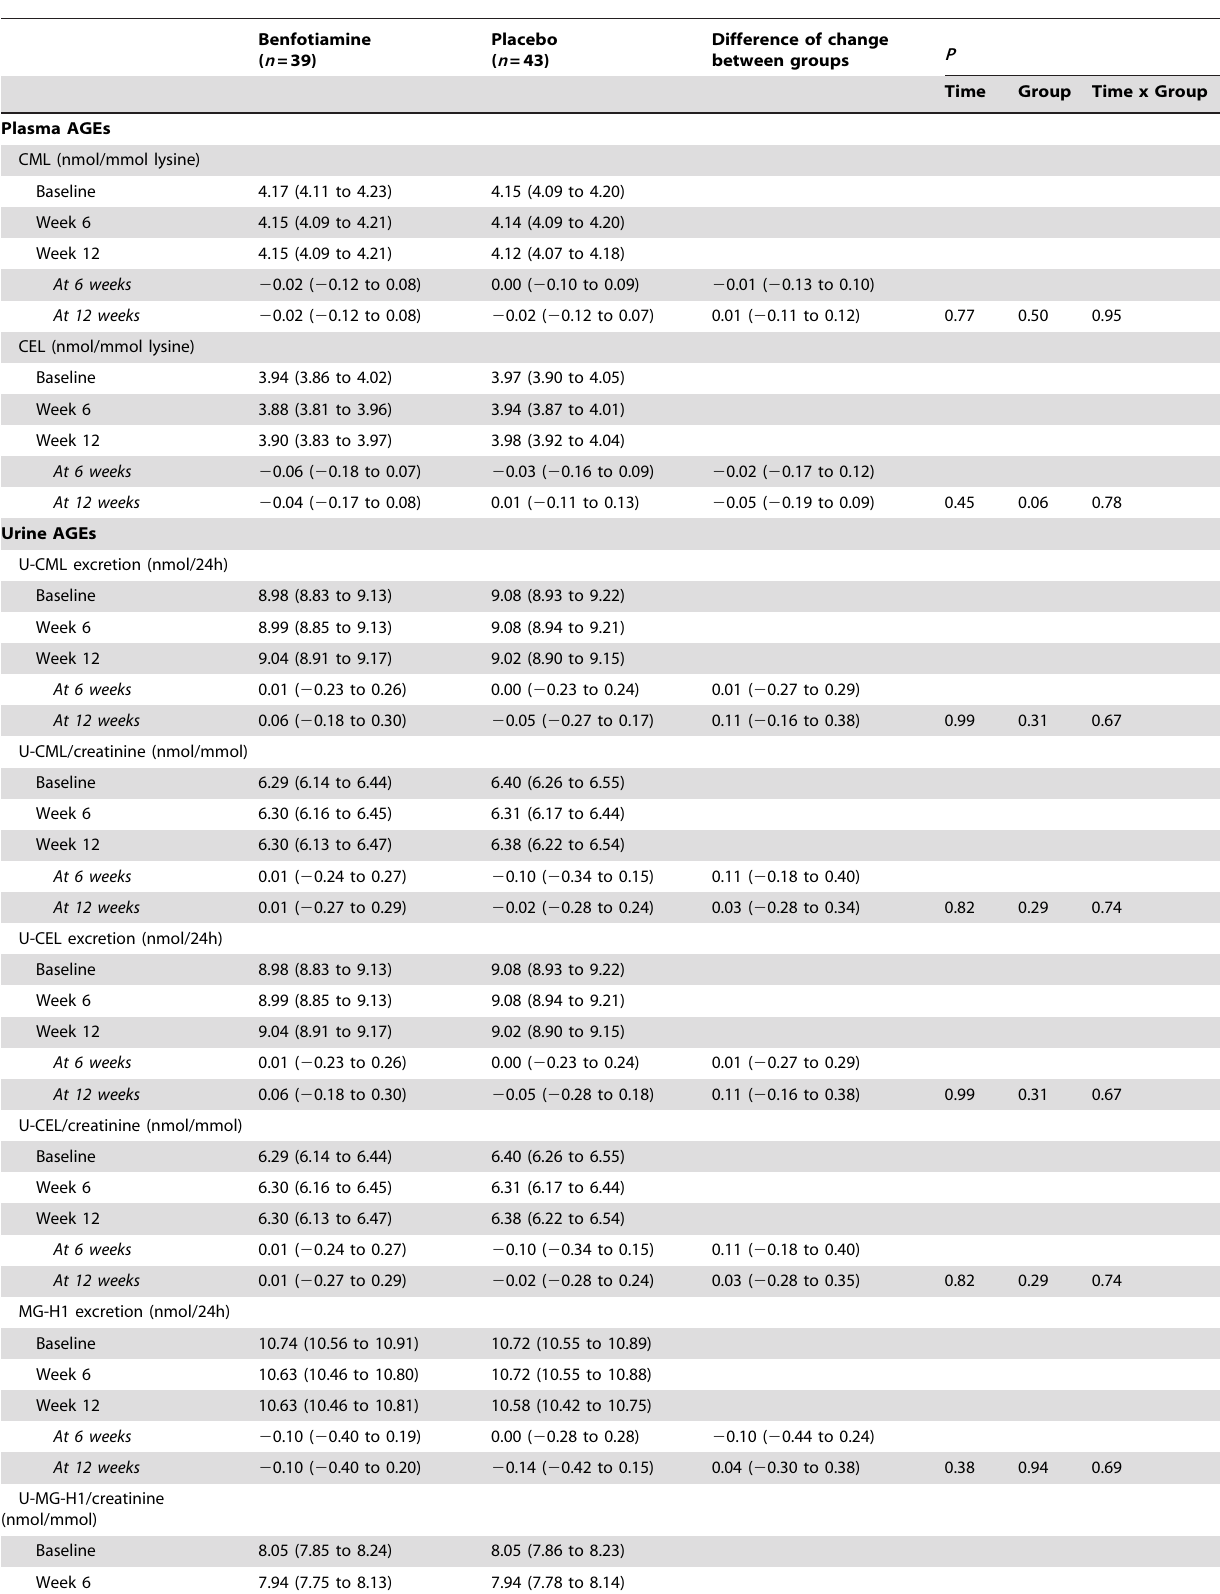
Table 2. Estimated means of the log-transformed data at each visit, changes within group compared to baseline, and mean differences of change between groups compared to